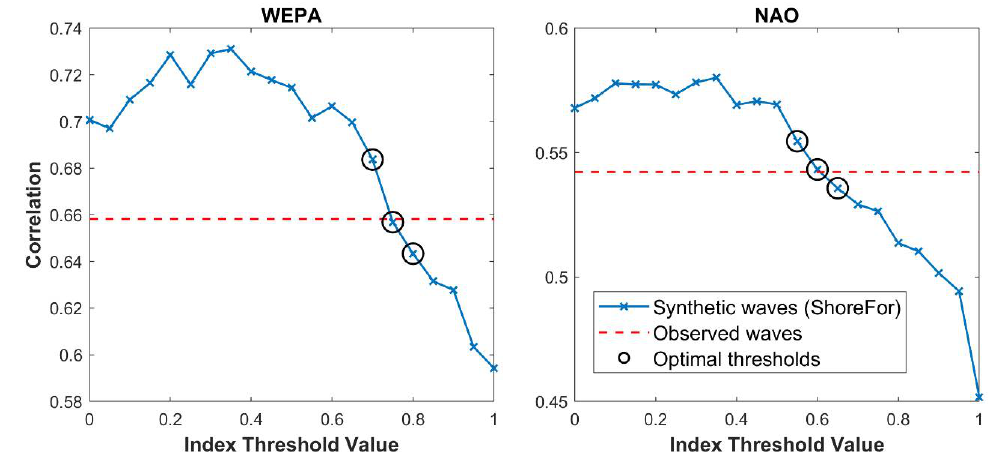
Figure 5. Optimising the WEPA-informed (left) and NAO-informed (right) synthetic waves. The correlation between monthly wave power and the indices is shown for the synthetic waves (blue) as the threshold is varied, against the observed correlation from the historic wave data (red dashed).